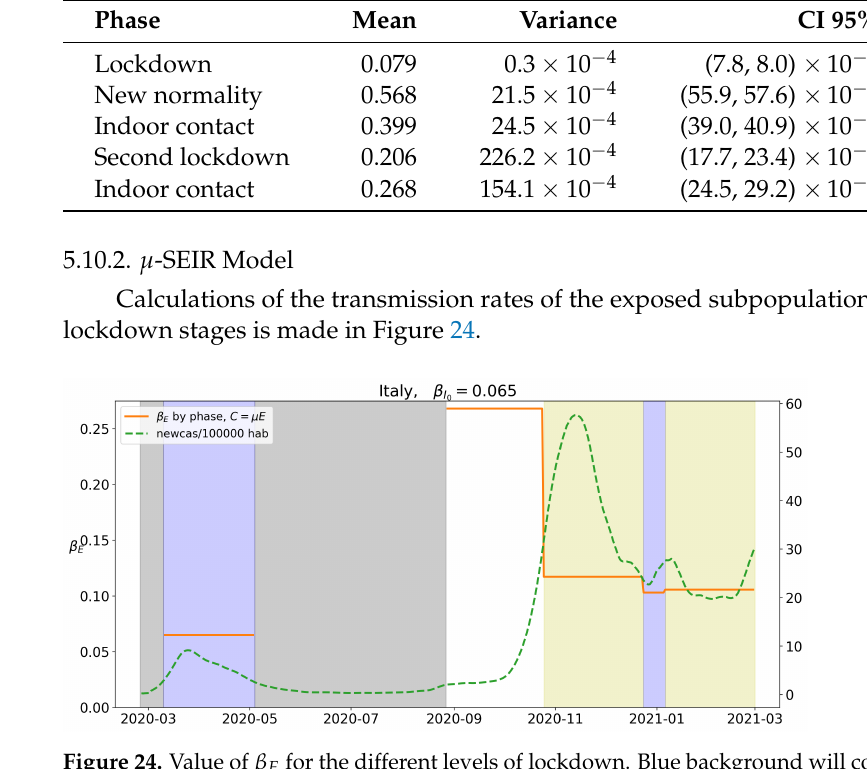
Figure 24. Value of β E for the different levels of lockdown. Blue background will correspond to Stage 1, red to Stage 2, yellow to Stage 3 and white to Stage 4. A green dotted line corresponds to the value of new cases per 100,000 hab.